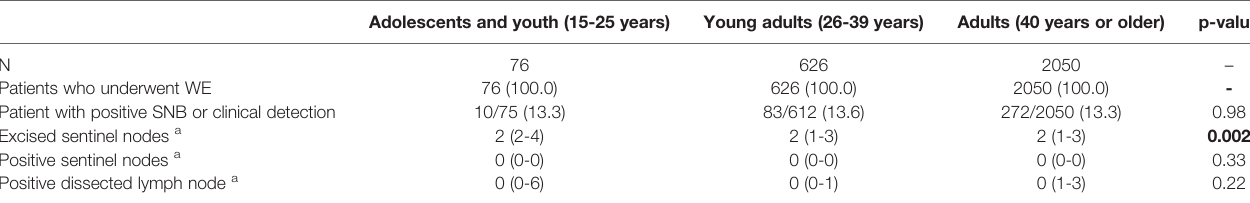
TABLE 2 | Treatment of primary Melanoma of the skin in 2,752 patients aged ≥ 15 years and living in the Veneto Region who were diagnosed and/or treated for Melanoma between 1998-2014 at the Veneto Institute of Oncology and at the University Hospital of Padua (Italy): comparison between age classes (15-25 years, 26-39 years, 40 years or older).